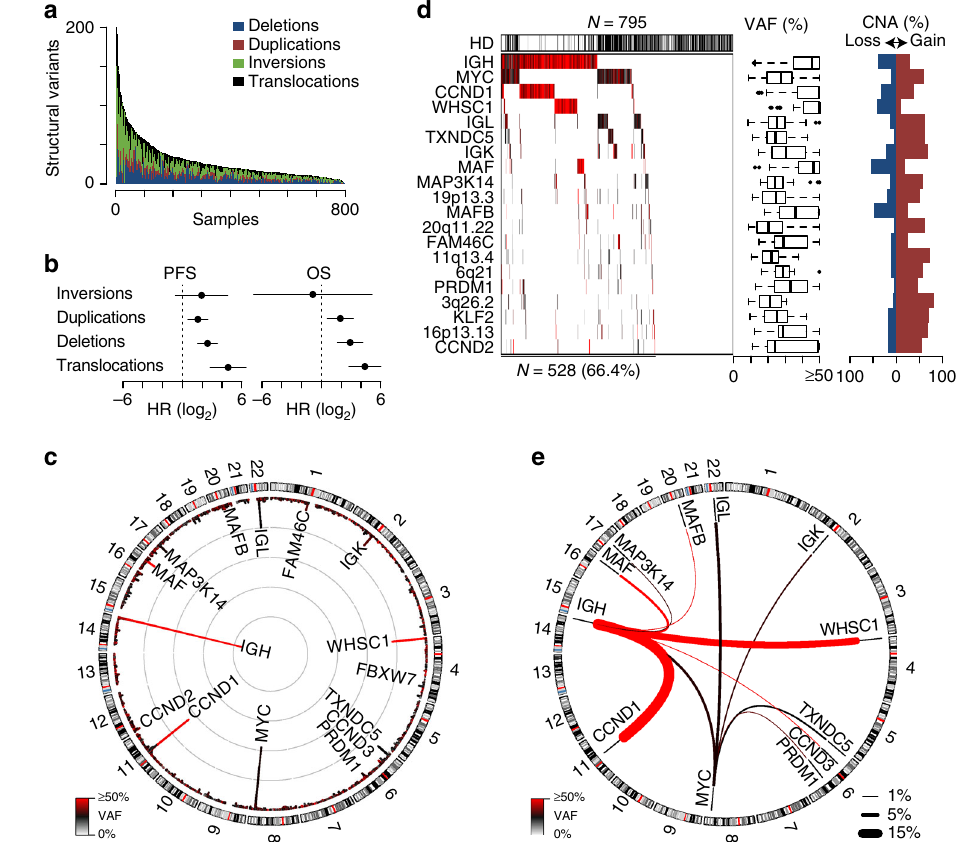
Fig. 1 Structural variants correspond with poor prognosis. a The number of somatic structural variants per sample in 795 newly diagnosed myeloma specimens ordered by the total number of structural variants. Three samples are cropped at 200 structural variants, but have 1823, 529, and 257 SV. b Progression-free (PFS) and overall survival (OS) hazard ratios (HR) for structural variants indicating the increased hazard of having the maximum number of each structural variant, with 95% con fi dence intervals shown. c Circos plot of translocation frequency. The frequency of translocations is plotted on the inside with gray concentric circles denoting 10 percentiles per megabase and the color of each region represents the median variant allele frequency (VAF; key bottom left). Chromosome ideograms are represented and labelled on the outside. d Waterfall plot of translocated regions showing those present in ≥ 2% of newly diagnosed patients (left). Hyperdiploid (HD) status is denoted above. The VAF of each translocation is denoted in color and summarized in boxplots (middle) showing the median and quartiles with the whiskers extending to the most extreme data point within 1.5 times the interquartile range. The frequency of proximal ( ≤ 10 kb) copy number alterations (CNA) associated with each translocation are shown (right). e Circos plot of translocated regions prevalent in ≥ 1% of samples. The thickness and color of lines connecting two regions denotes the frequency and median VAF of the translocation, respectively (see keys bottom right and left). Hazard ratios were determined using a Cox proportional hazards regression Wald ’ s test as a function of the number of structural events. Source data are provided as a Source Data fi